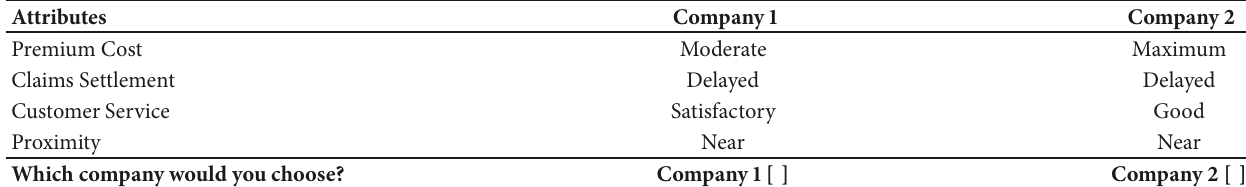
Table 3: Choice set presented to respondents. Which of these two companies do you want?